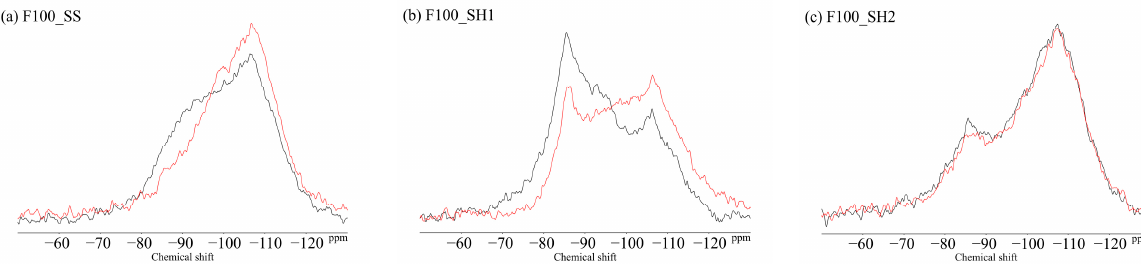
Figure 14. Solid-state 29 Si MAS NMR chemical shifts for ( a ) F100_SS, ( b ) F100_SH1, and ( c ) F100_SH2 samples.